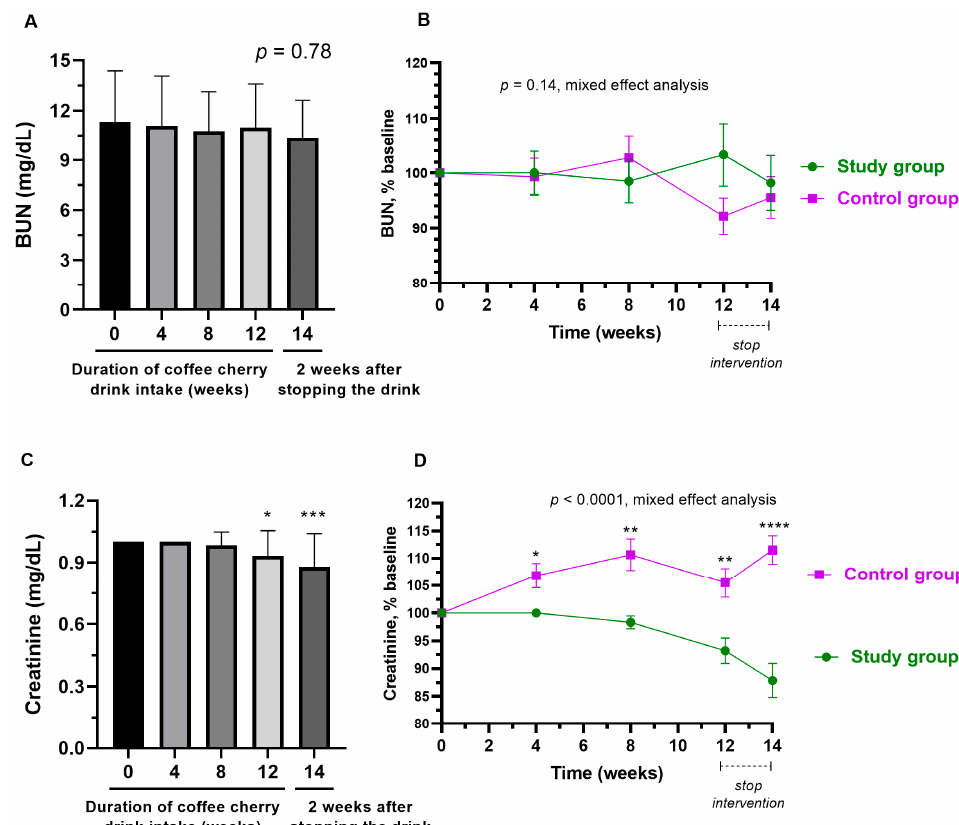
Figure 7. Changes in BUN and creatinine. The bar graphs show the mean and standard deviation of BUN ( A ) and creatinine ( C ) after consumption of cherry coffee pulp juice concentrate for 4, 8, and 12 weeks, and 2 weeks after stopping the intervention (14 weeks), with p -value obtained from the Kruskal–Wallis test; the line graphs show a comparison of the mean and standard deviation of the BUN ( B ) and creatinine ( D ) in the percentage of the respective baseline values (% baseline) at each time point between study (green) and control (purple) groups, with p -value obtained from mixed-effect analysis. *, **, ***, and **** mean p < 0.05. 0.01, 0.001 and 0.0001, respectively.